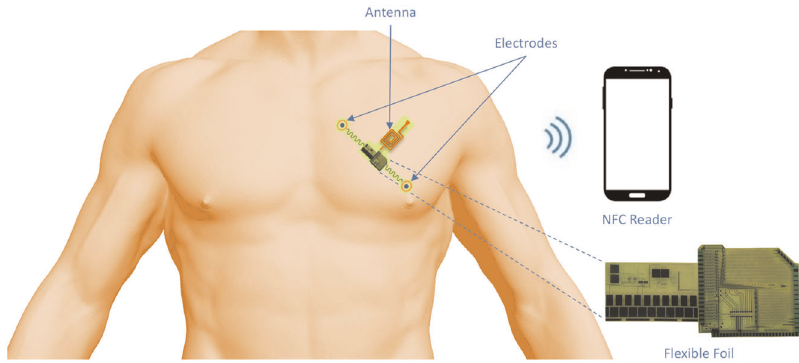
Fig. 1 Application scenario. The presented ECG patch in a representative application